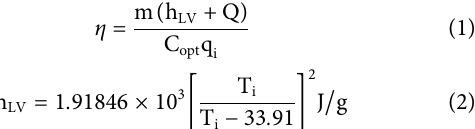
FIGURE 2 | Schematic diagram of the experimental